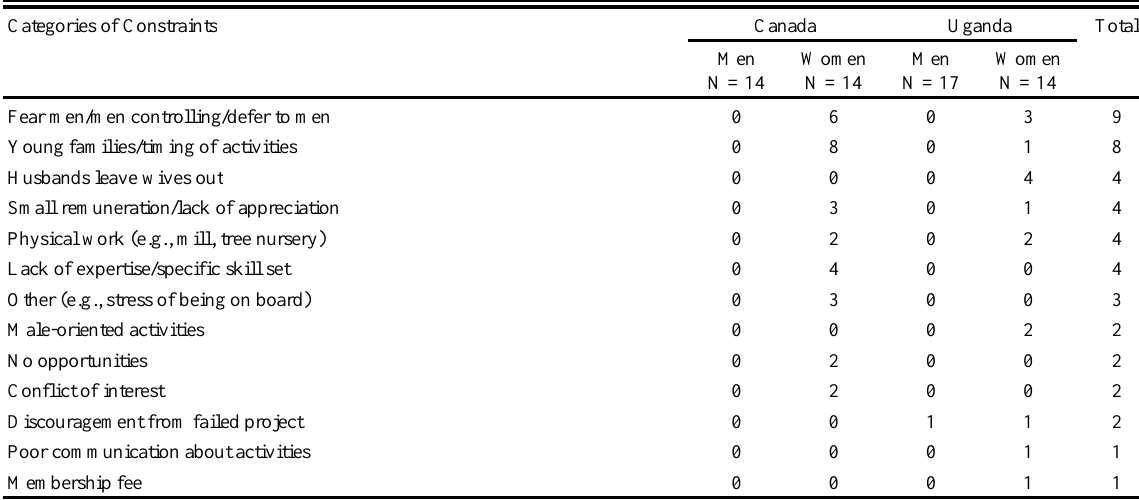
Table 6. General constraints mentioned during interviews.